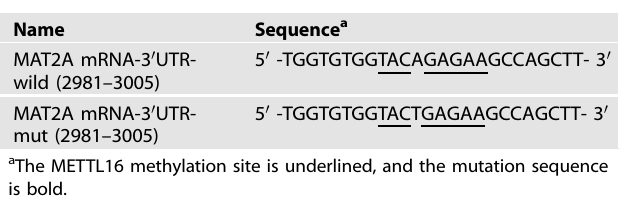
Table 3. The sequence of wild and mutant-MAT2A mRNA-3 ′